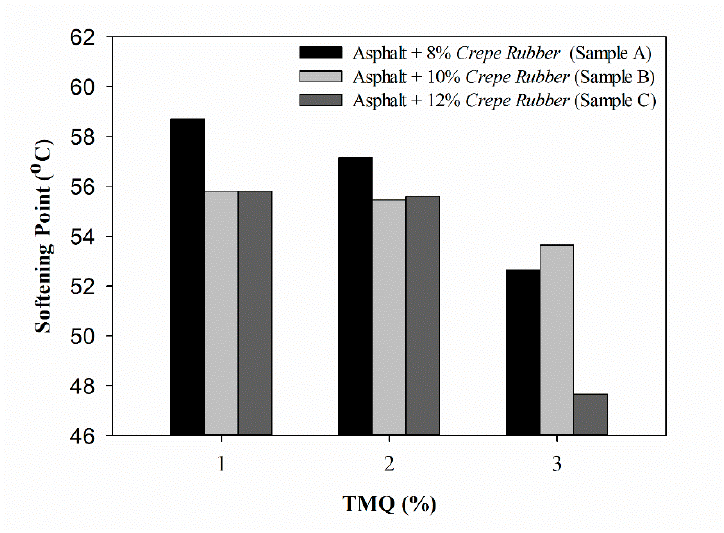
Figure 2. Softening point.